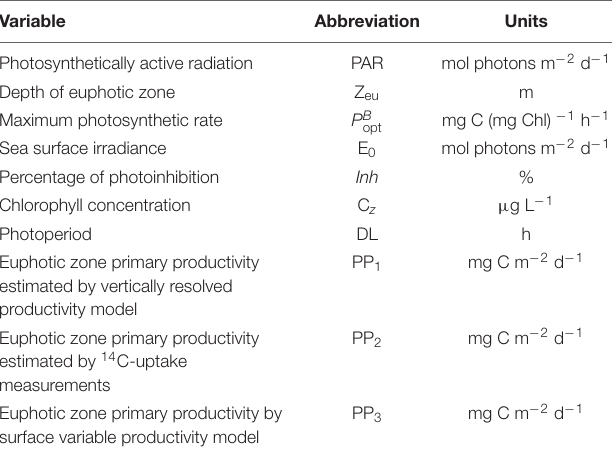
TABLE 1 | The variables used in the two bio-optical models and their units, and the types of primary productivity